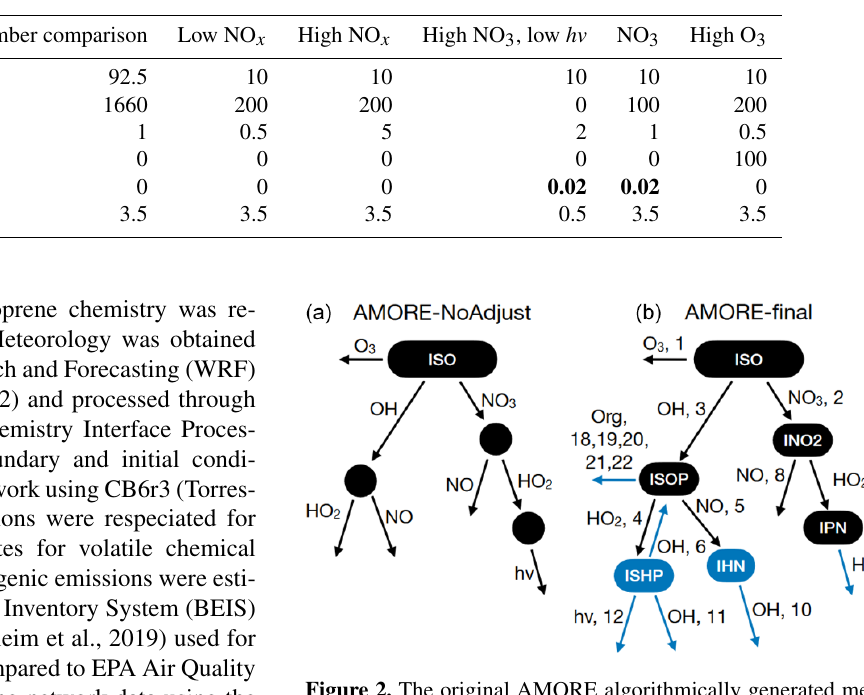
Table 3. F0AM box model testing input conditions used for calculating the error metric and evaluating the AMORE-Isoprene mechanism. Bold values represent species concentrations that were held constant. All other concentrations varied with time after initiation of the simula- tion.